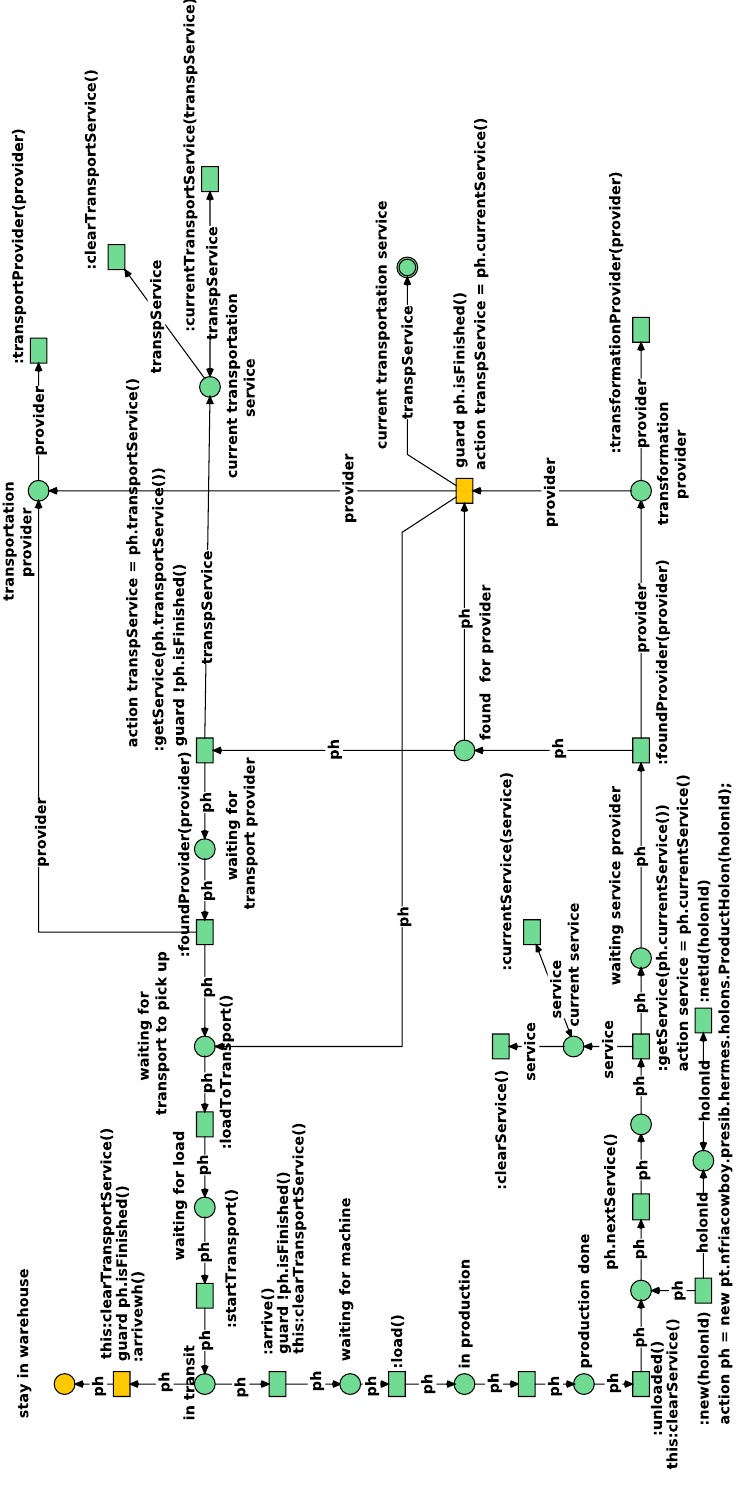
Figure 11. ProductHolon net Figure 11. Product holon